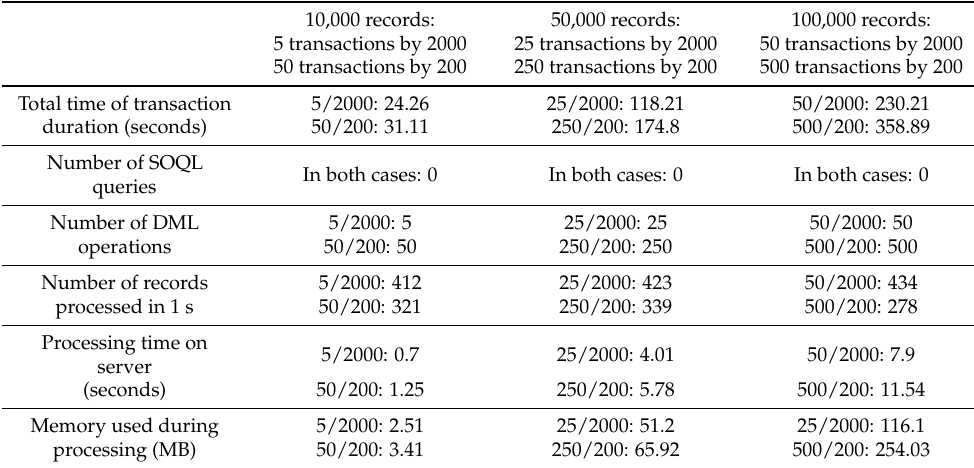
Table 2. Batch Apex processing results for delete operation.